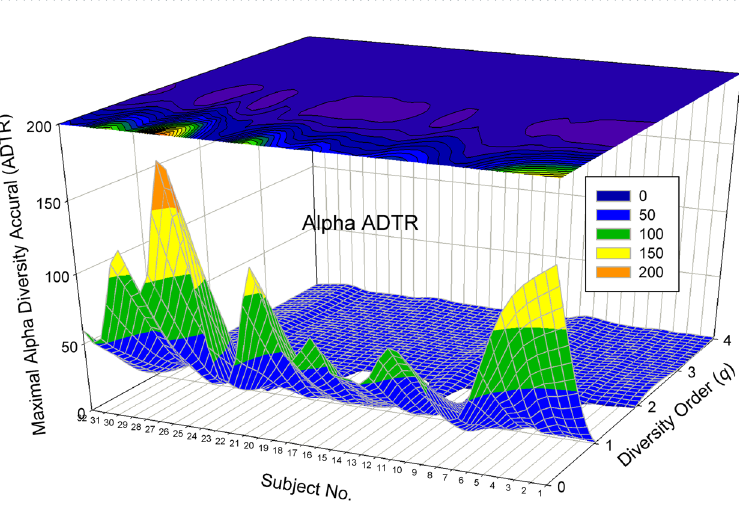
Figure 4. The 3D-graph of the PLEC exponent ( w ) of beta beta - DTR.